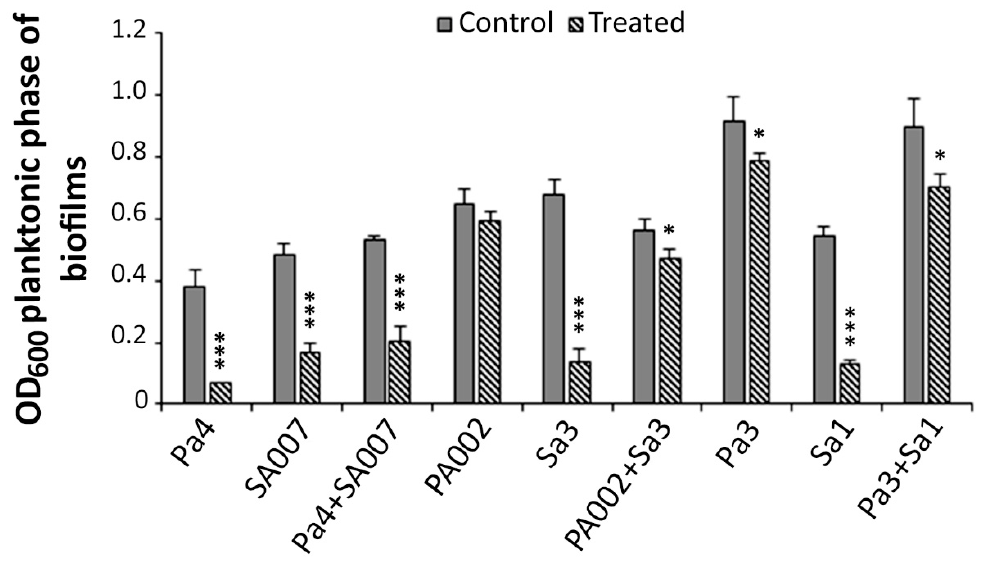
Figure 2. E ff ect of peptide Hs02 on the proliferation of 24-h preformed biofilms. The OD 600 of planktonic phases of biofilms was measured and used to infer the biofilm proliferation. Pa4 and SA007 biofilms were treated with 8 × MIC (32 µ g / mL in both cases) of peptide Hs02; the dual-species biofilm of Pa4 + SA007 was also treated with the same concentration. PA002 and Sa3 biofilms were treated with 8 × MIC; that is, 128 µ g / mL and 64 µ g / mL, respectively, while the dual-species biofilm PA002 + Sa3 was treated with 128 µ g / mL. Pa3 and Sa1 biofilms were treated with 8 × MIC; that is, 40 and 80 µ g / mL, respectively, while the dual-species biofilm Pa3 + Sa1 was treated with 80 µ g / mL. Two independent experiments were performed in triplicate. Error bars represent SD. Statistically significant di ff erences in comparison to the control are highlighted for p < 0.001 (***) or for 0.01 ≤ p < 0.05 (*). OD 600 : optical density at 600 nm.